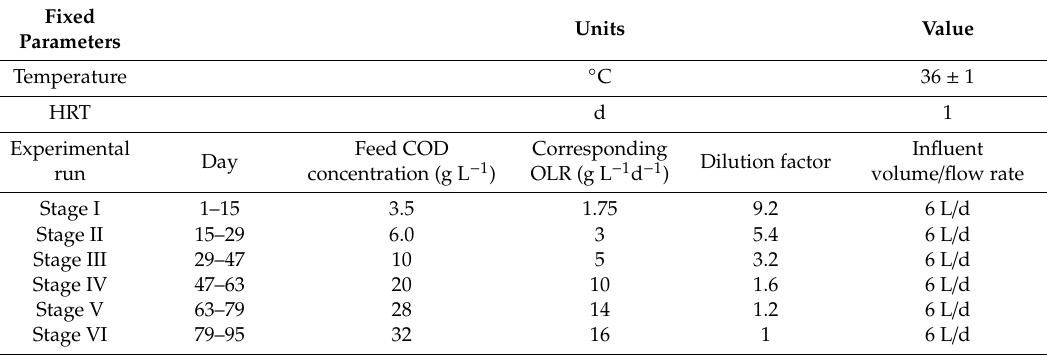
Table 2. Startup strategy of conventional and the modified UASB